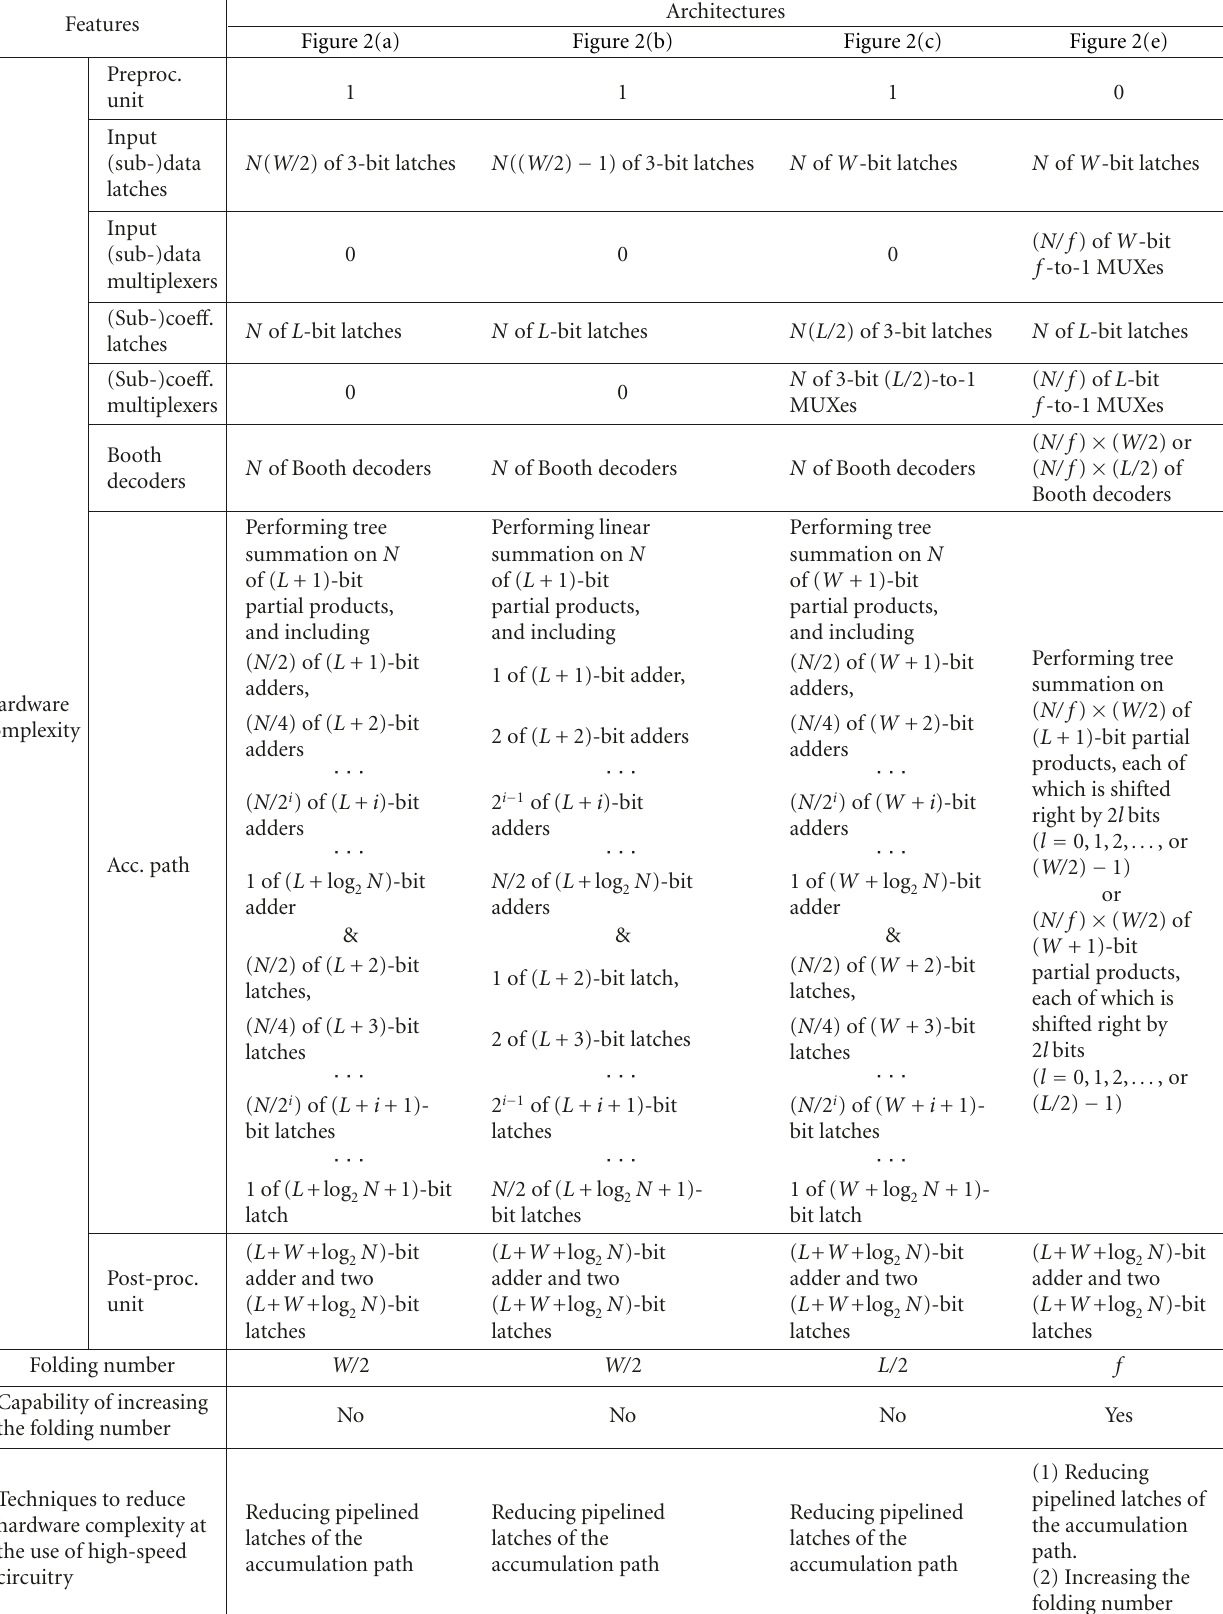
Table 1: Features of functional units of the architectures in Figures 2(a), 2(b), 2(c), and